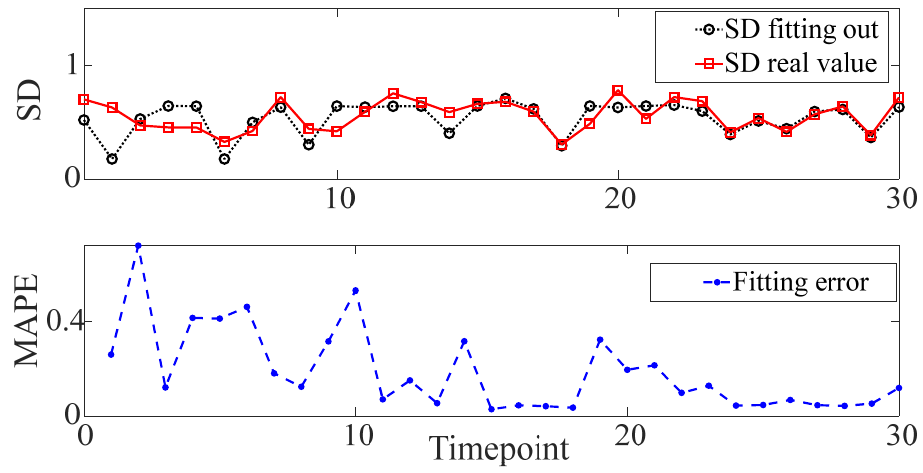
Figure 7. Fitting results and fitting errors of SSA ‐ BP HM.